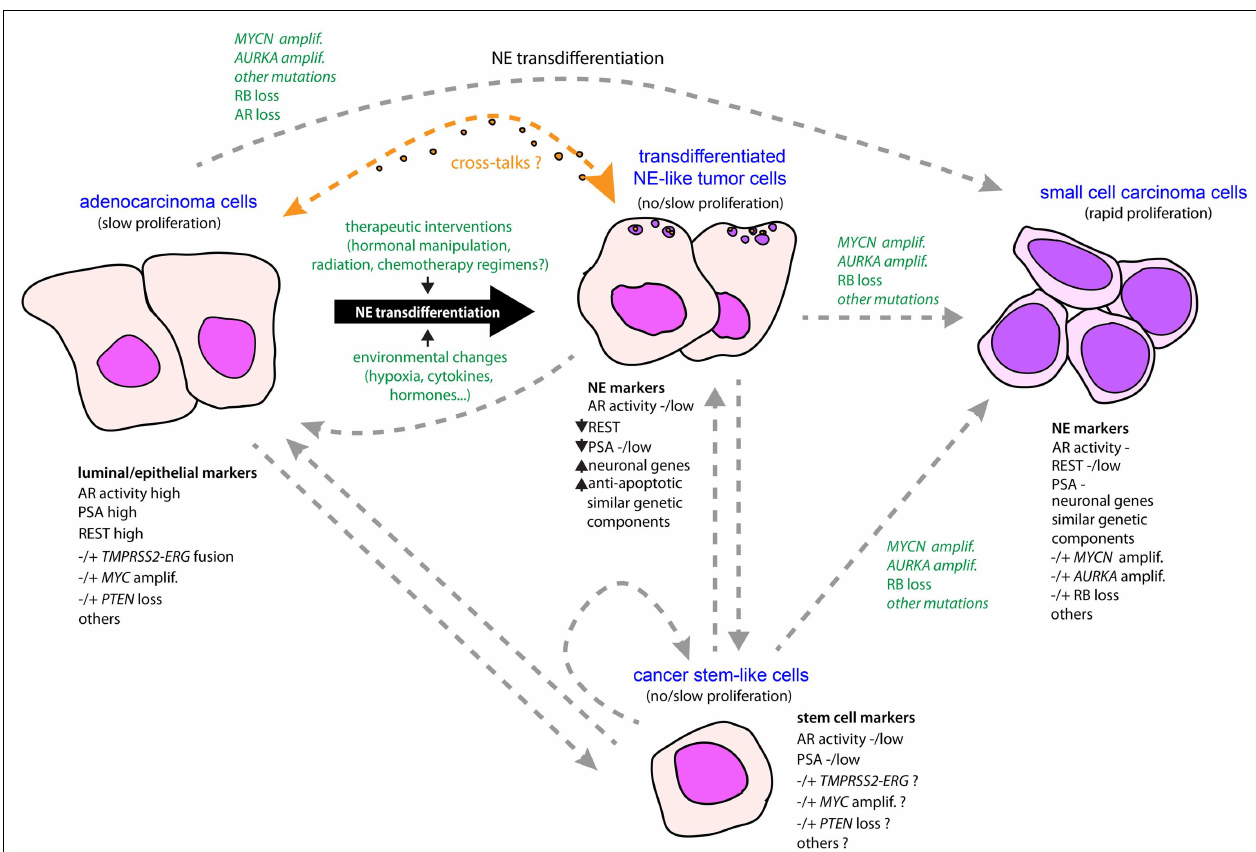
AURKA, and MYCN amplifications under evolutionary pressures, or through natural selection of preexisting NE-like tumor subpopulations, may promote rapid cell expansion and subsequent emergence of a predominant NE component in the form of small-cell carcinoma characterized by rapid proliferative activity. Alternatively, small-cell carcinoma could arise by direct transformation of adenocarcinoma. Adenocarcinoma and small-cell carcinoma components may also originate from a common tumor clone with stem-like properties, or a cancer stem cell, converted into more differentiated tumor cells that accumulated molecular alterations driving epithelial or NE phenotypes.To date, very limited amounts of data are supportive of normal prostatic NE cell as a cell of origin for NE tumors (not shown